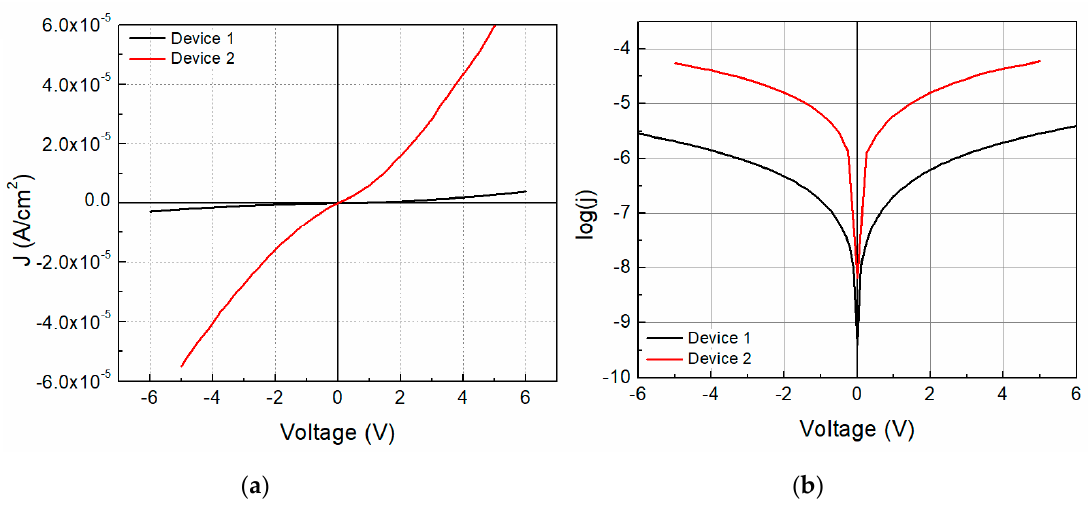
Figure 5. ( a ) J-V characteristics and ( b ) log(J)-V curves for the fabricated